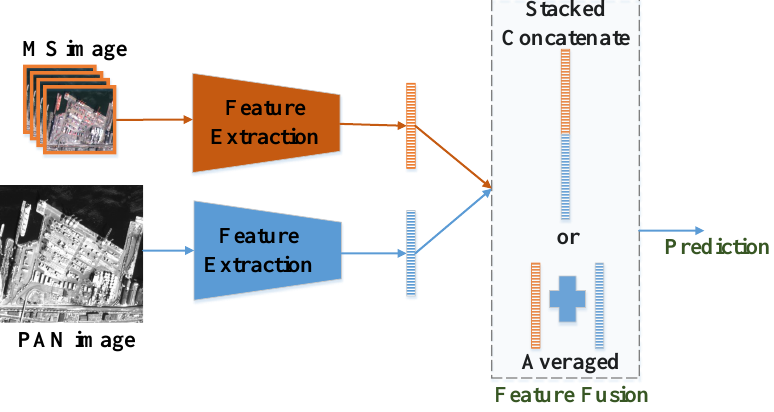
Figure 1. General framework of MS and PAN image classification based on a classification-based fusion model. (Quickbird satellite with 2.44-m MS image and 0.61-m PAN